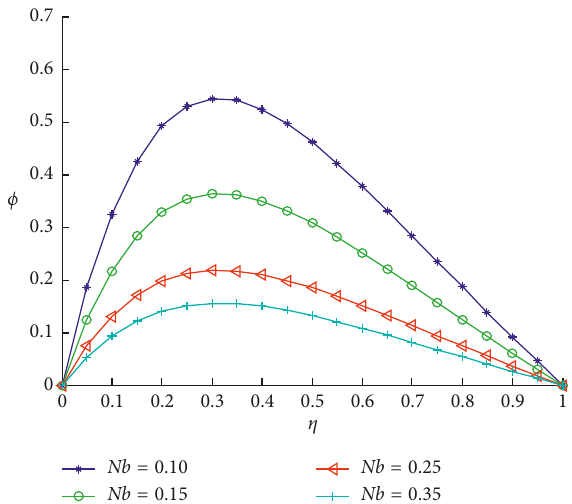
Figure 15: Effect of the Lewis number on the concentration profile when A 1 . 0 , and C